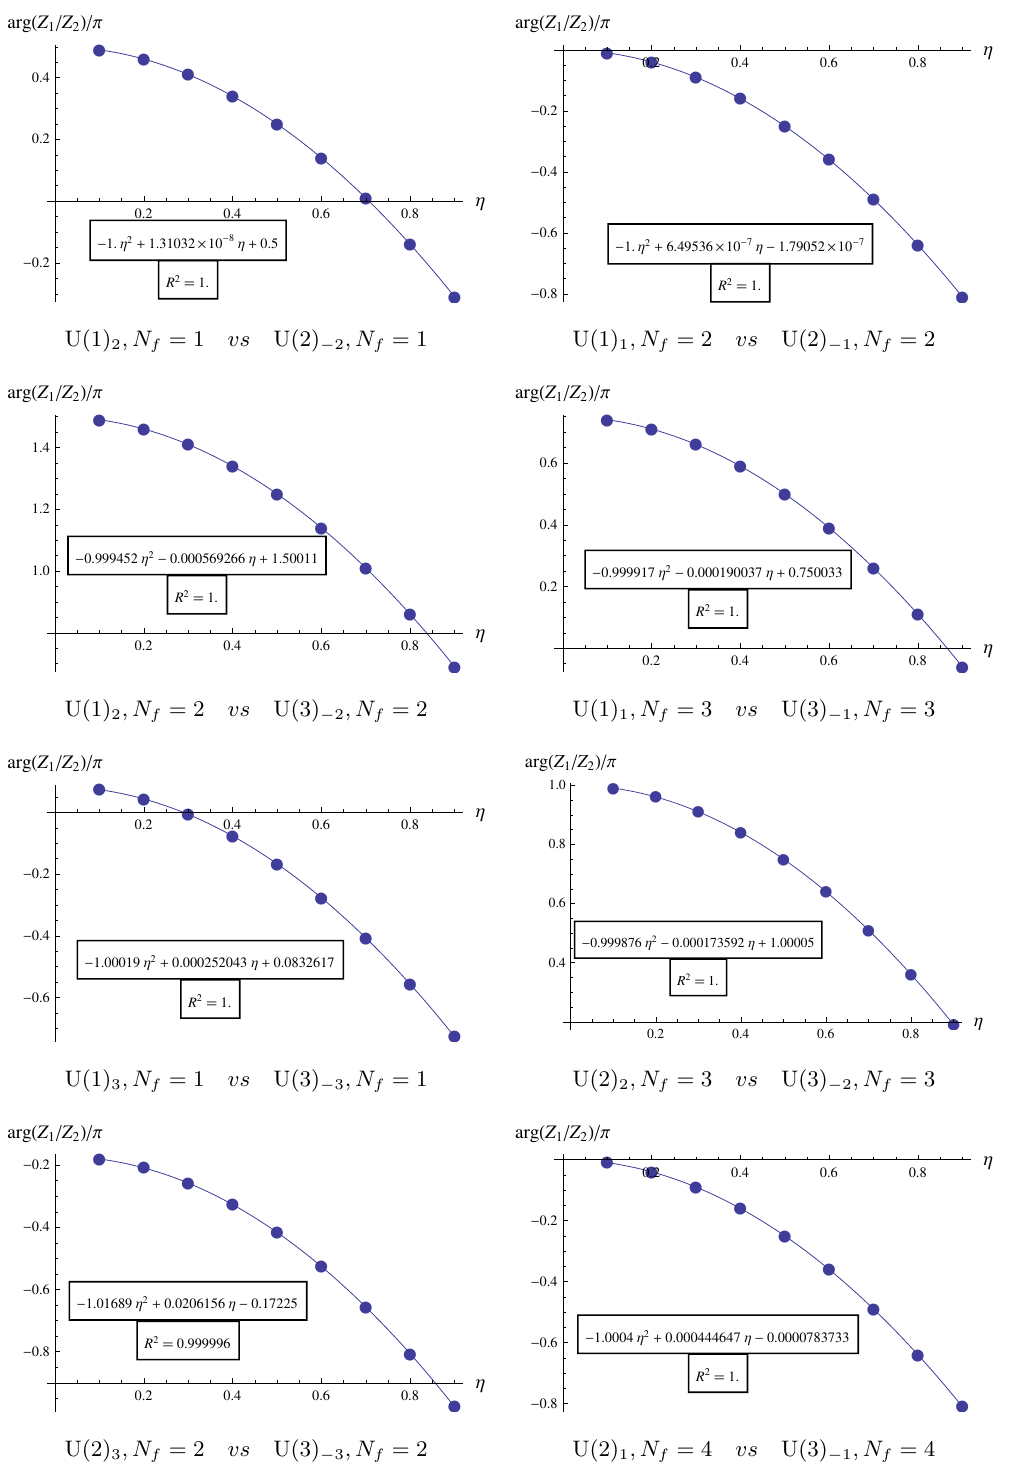
Figure 5 . A plot of the phase di(cid:11)erence of the partition functions with FI deformation ( (cid:17) ) for 8 dual pairs and values of (cid:17) from : 1 to : 9 and a best (cid:12)t parabola.